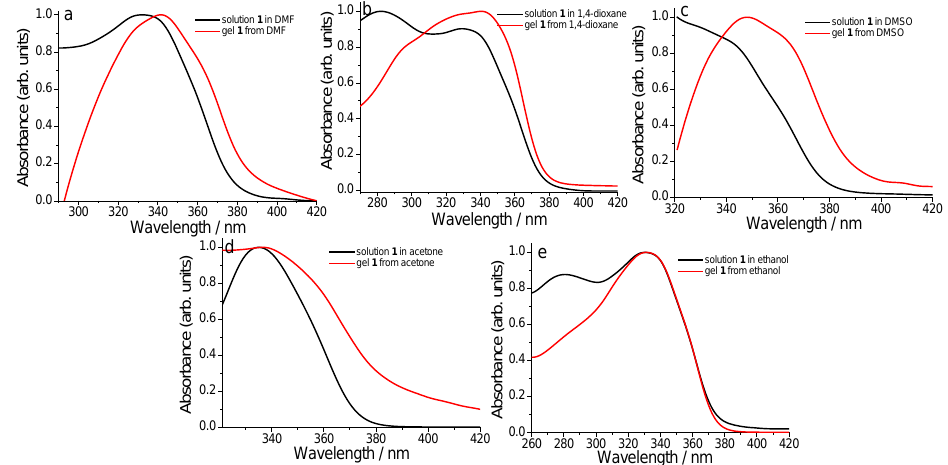
Figure 3. UV-vis absorbance spectra of compound 1 in solution and gel states. ( a ) DMF, ( b ) DMSO, ( c ) 1,4-dioxane, ( d ) acetone, ( e ) ethanol. The concentrations of solution and gel were 10 −5 M and at its corresponding CGC, respectively.